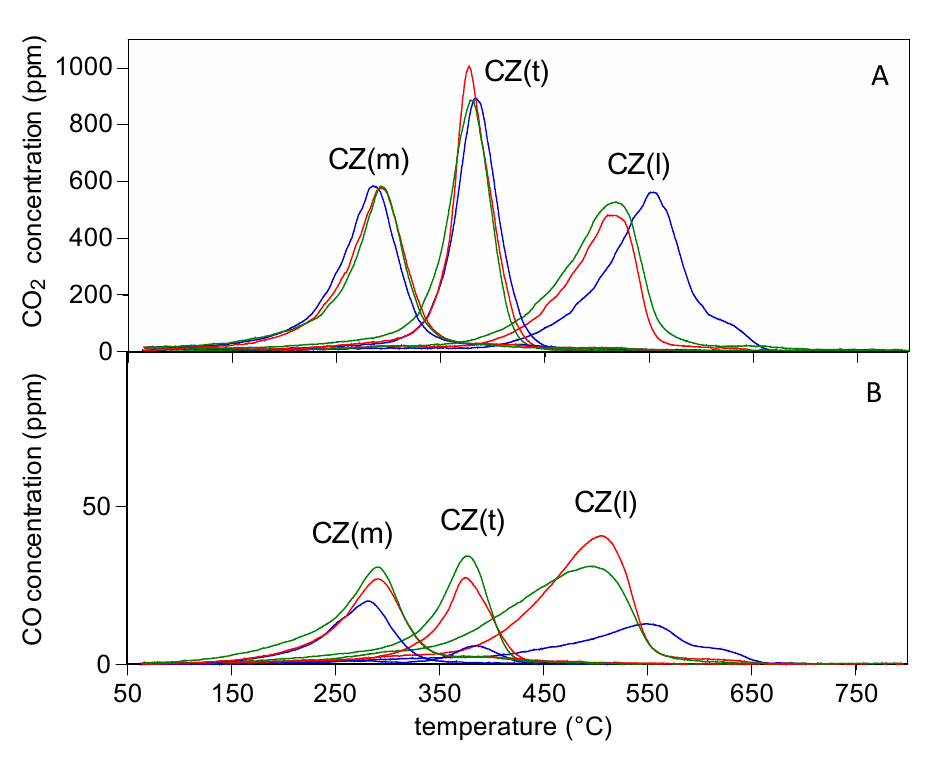
Figure 4. ( A ) CO 2 evolution and ( B ) CO evolution from temperature programmed oxidation (TPO) profiles for CZ/C mixtures at different mixing condition and different atmosphere: O 2 (blue), NO+O 2 (red) and NO 2 +O 2 (green).